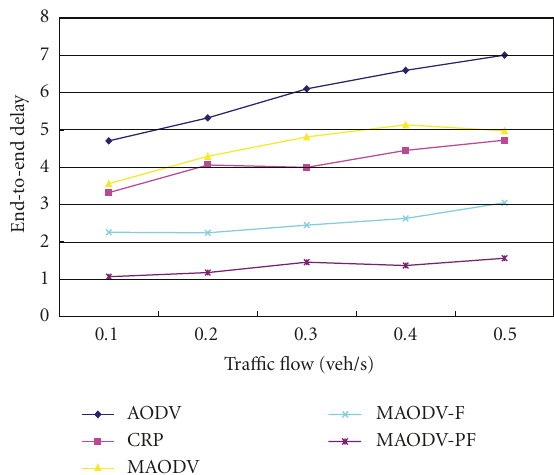
Figure 11: End-to-end delays for CRP, AODV, MAODV, MAODV- F, and MAODV-PF under di ff erent tra ffi c flows.